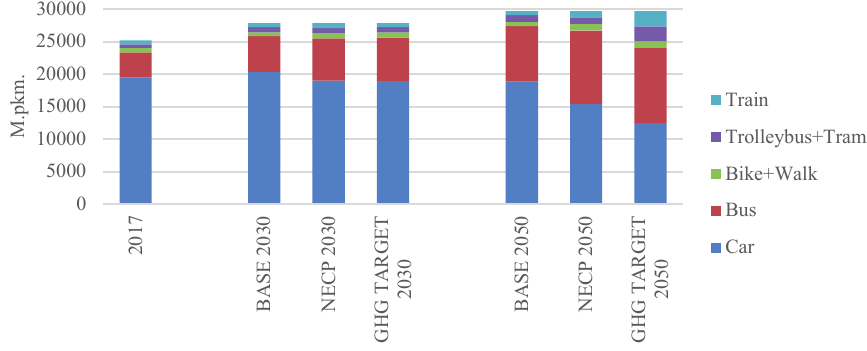
Fig. 14. Projection of the use of passenger transport modes for alternative